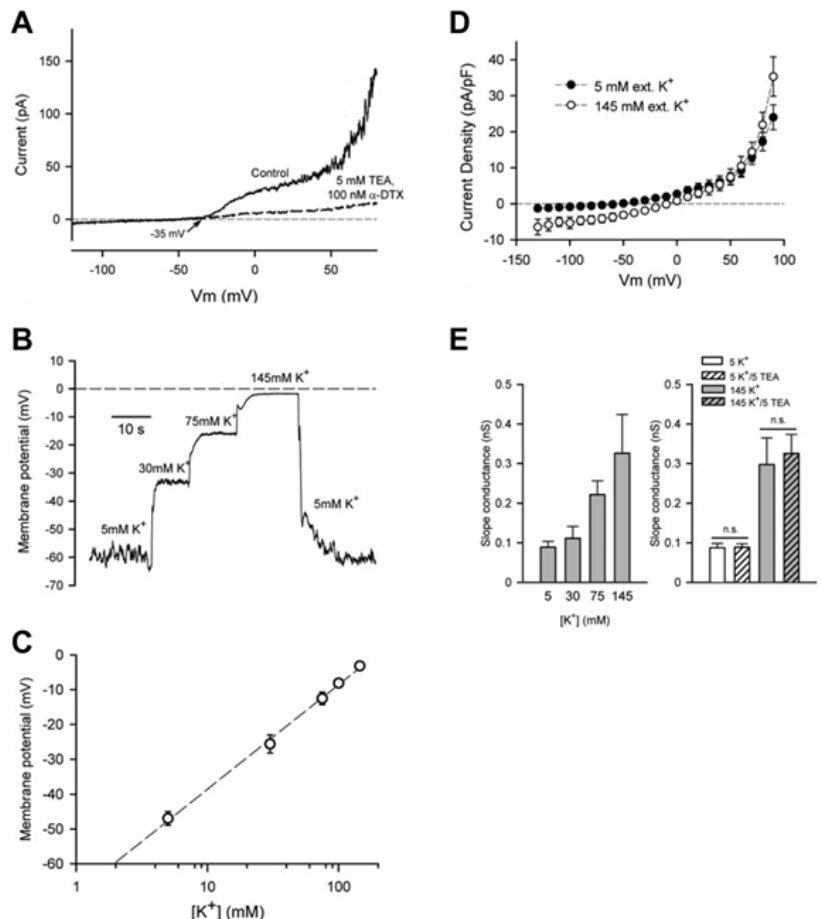
Figure 1. Resting membrane potential and K + currents in an isolated human articular chondrocyte.